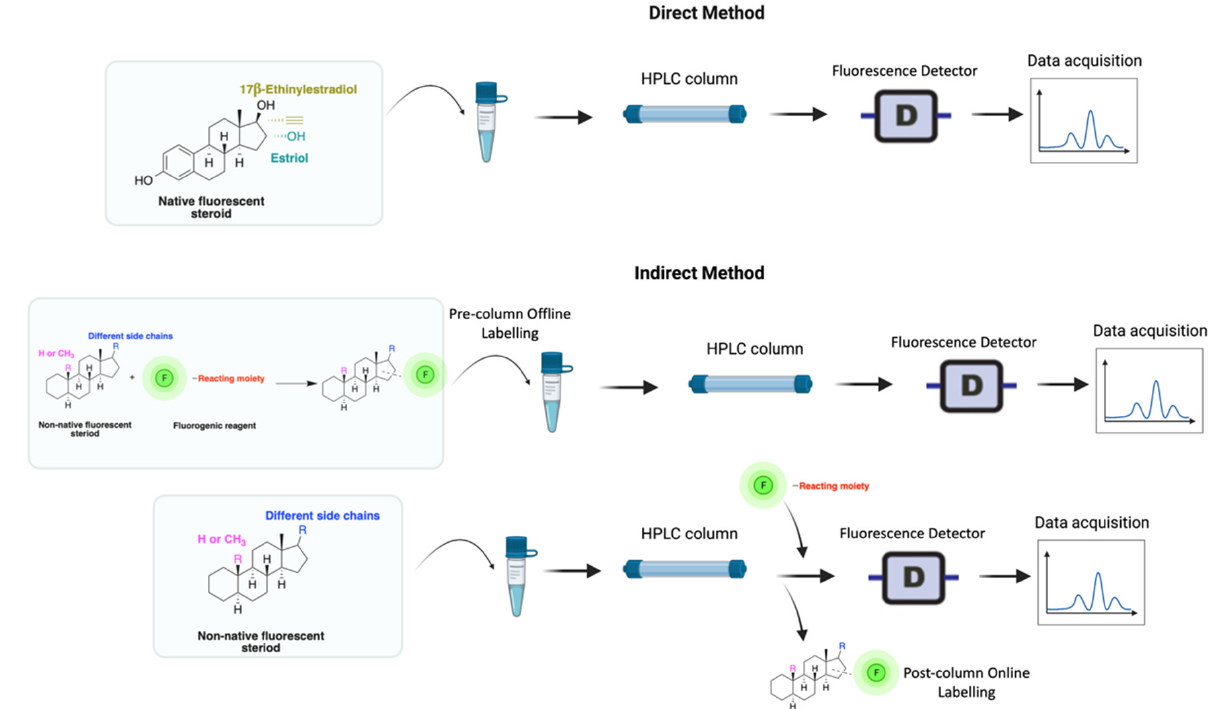
Figure 2. Derivatization using fluorophore-containing reagents for steroids analysis by HPLC-FLD.